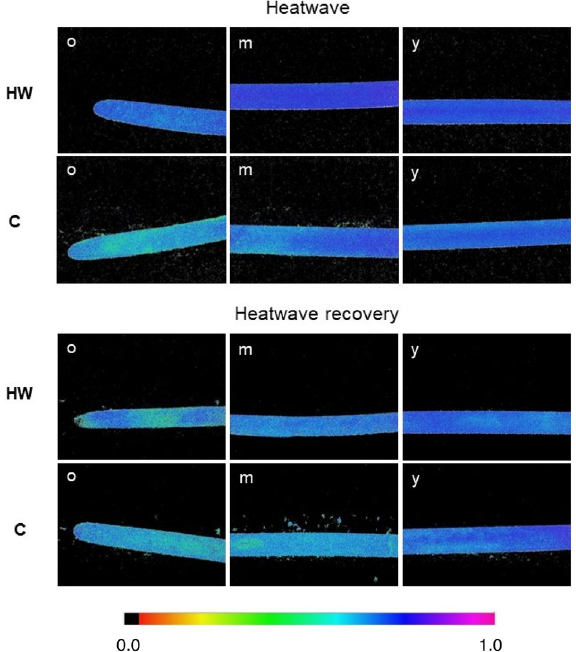
Figure 2. Examples of CFI pictures of C. nodosa ’s Φ PSII , after a saturating light pulse. CFI was done on mature leaves sampled from shoots cultivated in heatwave (HW) and control (C) conditions, both during the heatwave and after heatwave recovery. o, m and y indicate different leaf parts (old, mature and young, respectively). Colour bar on the bottom indicates Φ PSII values ranging from 0.0 (black) to 1.0. (pink). Pictures are 24 × 32 mm (6 × magnification).